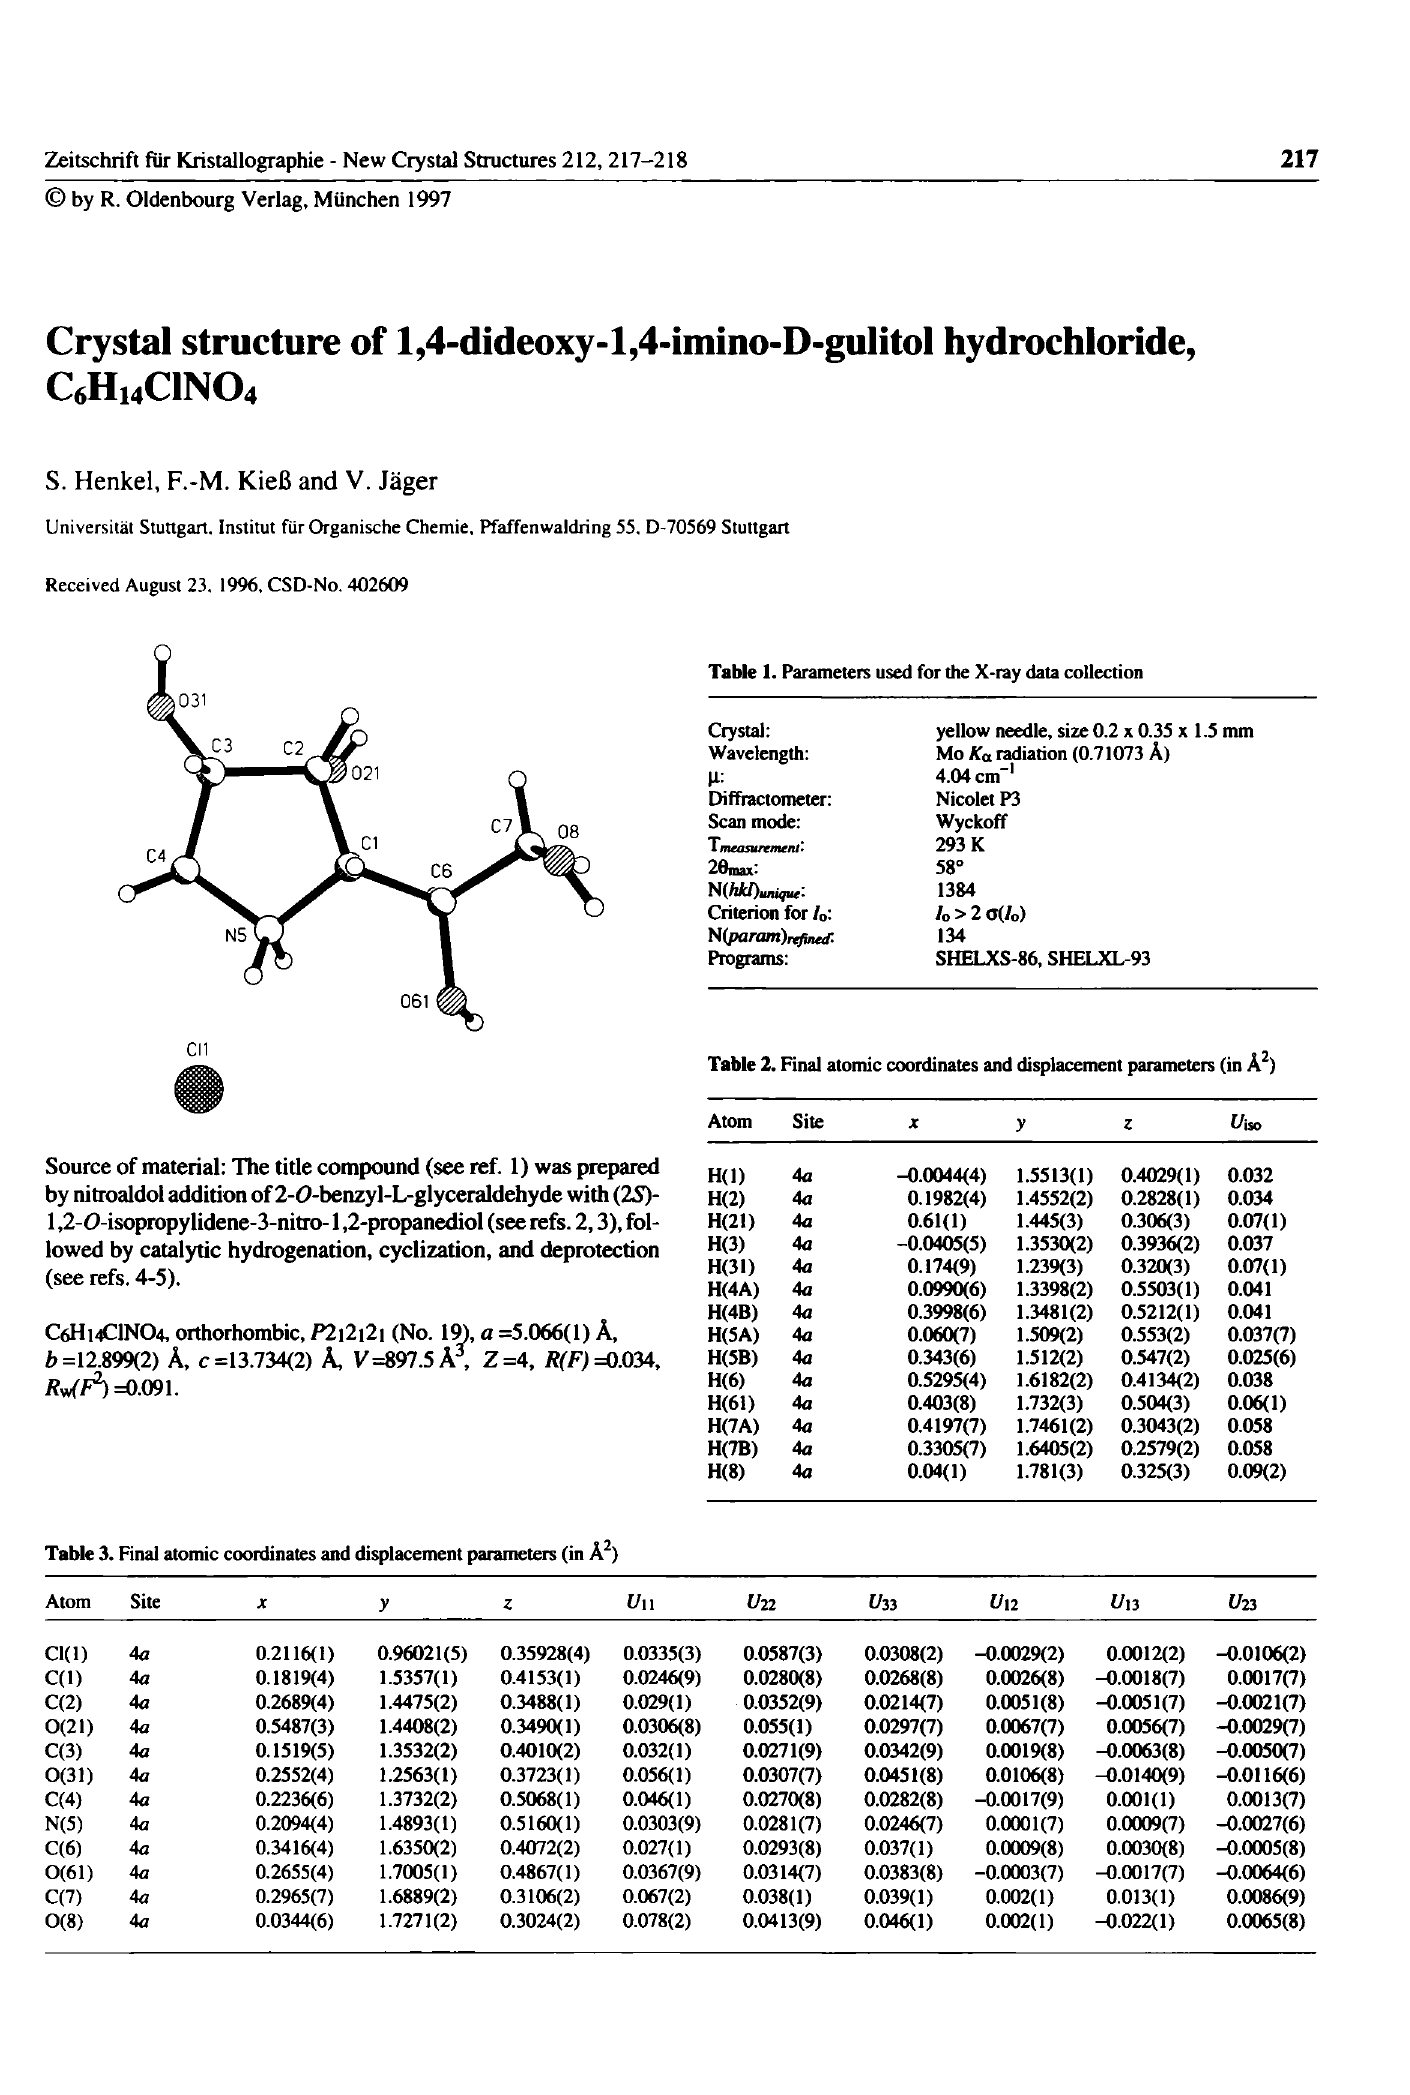
Table 1. Parameters used for the X-ray data collection